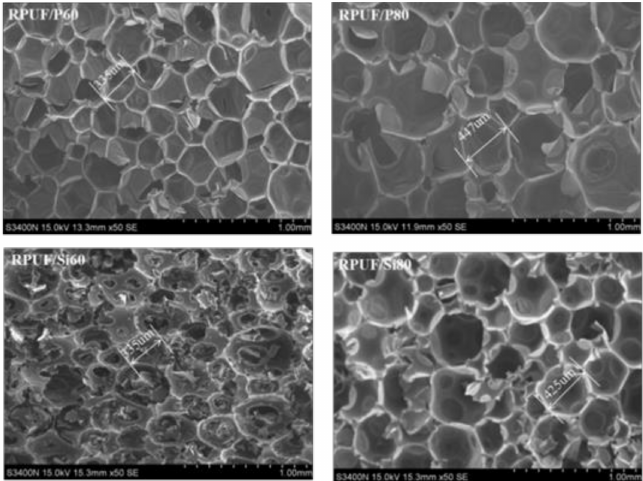
Figure 5. SEM of rigid polyurethane foam